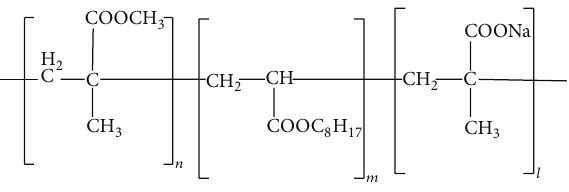
Scheme 1: Structure of the prepared